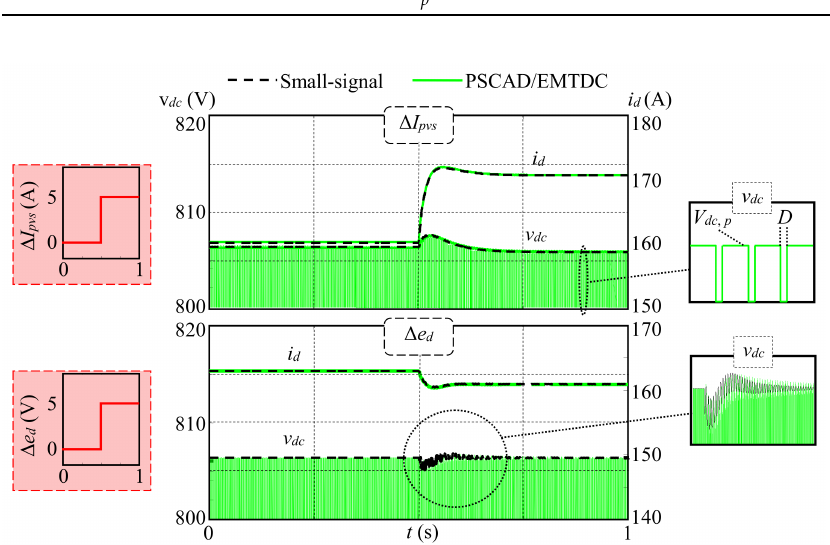
Figure 4. PSCAD validation of the qZSI-PV system